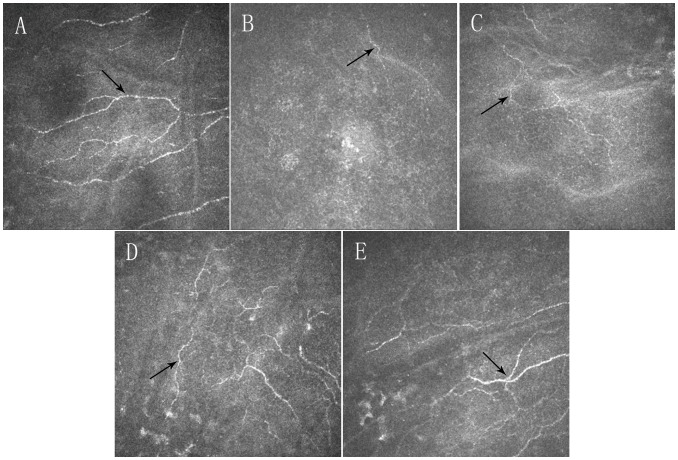
Confocal microscopy (HRT III) images showing time-dependent changes in the corneal subbasal nerve fibers in the central cornea in SMILE group.Preoperatively (A), intact corneal subbasal nerve fibers were noted (black arrow). At postoperative 1 week (B), 1 month (C), 3 months (D) and 6 months (E), subbasal nerve fibers were present in the central corneal area (black arrows). Postoperatively, the corneal subbasal nerve fibers appeared more tortuous compared to preoperative corneal subbasal nerve fibers (images acquired from the same subject). Field size: 400 µm×400 µm.